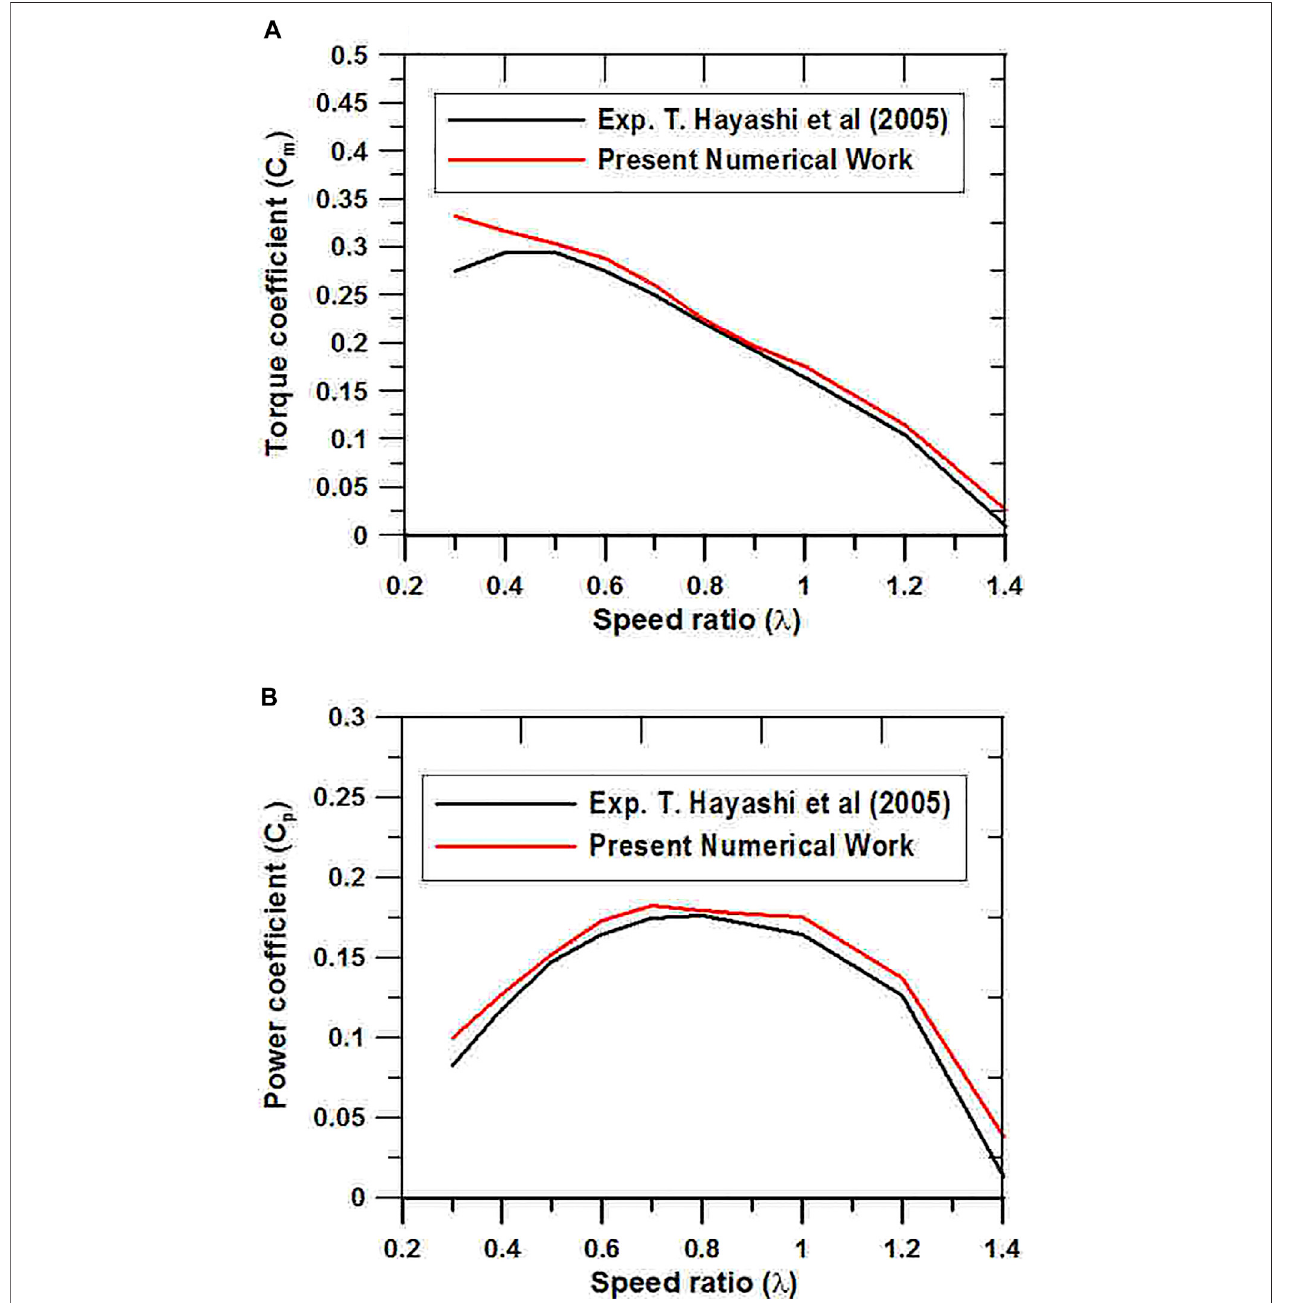
FIGURE 4 | Validation of the current CFD model. (A) Torque coef fi cient (top) , (B) power coef fi cient (bottom) , with comparison to published experiment result (Hayashi et al., 2005).